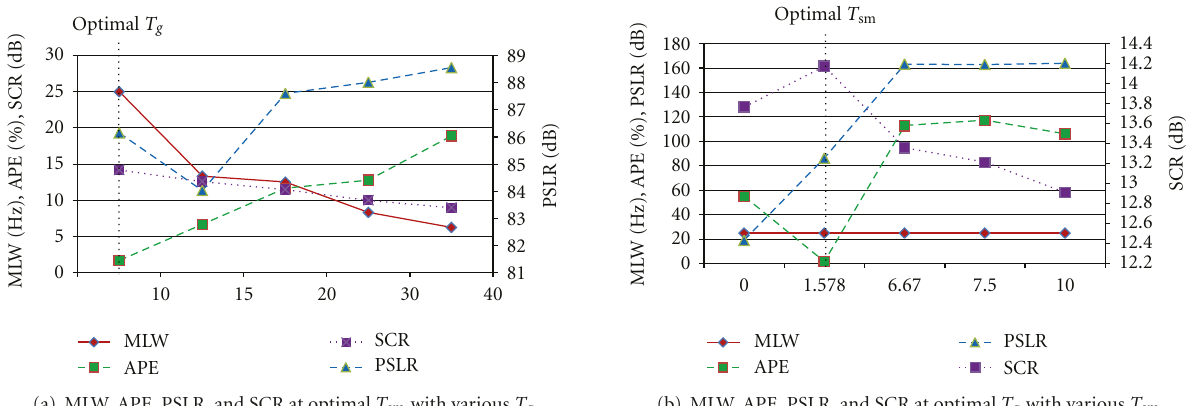
Figure 4: Performance of the TFR using SWWVD with various kernel parameters for transient signal. (The kernel parameters chosen must give low MLW and APE but high PSLR and SCR.)